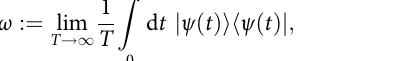
either between single subsystems of B (top) or multiple ones (bottom). Our